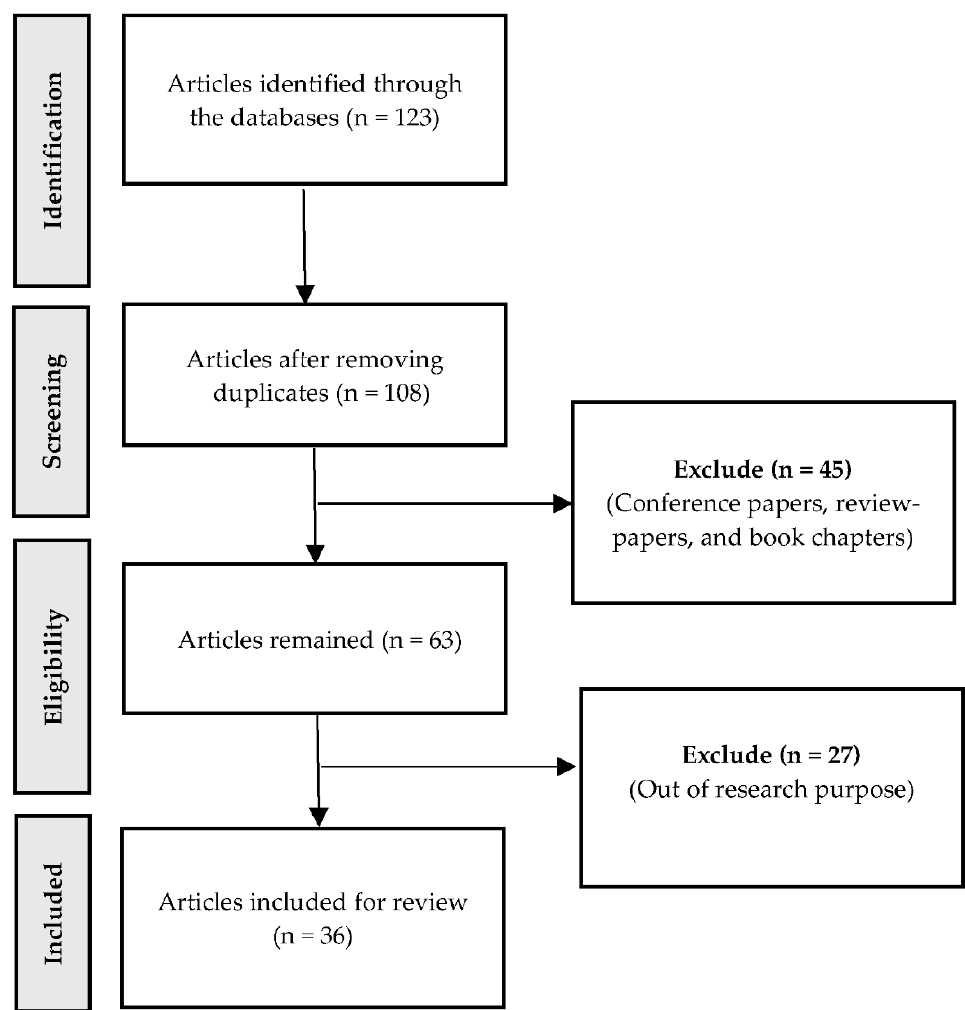
Figure 1. The systematic article selection process based on the PRISMA flowchart.